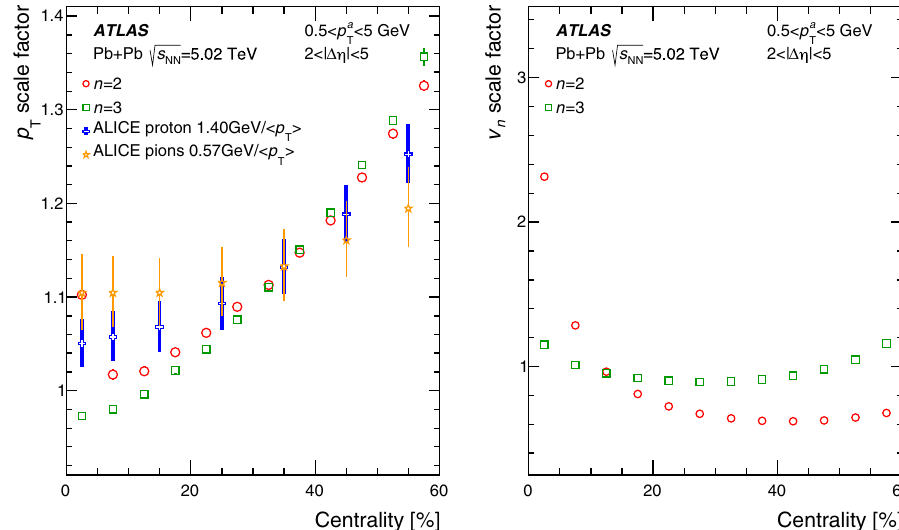
Fig. 14 Left panel: the x -scale factors for the v 2 ( p T ) and v ( p ) (see text) as a function 3 T of the collision centrality. Also shown for comparison are the ALICE 1/ (cid:3) p T (cid:4) for positively charged protons and pions (scaled by constant factors of 1.4 GeV and 0.57 GeV, respectively for plotting purposes). Right panel: the y -scale factors. The error bars on the scale factors and on the ALICE data indicate systematic and statistical uncertainties added in